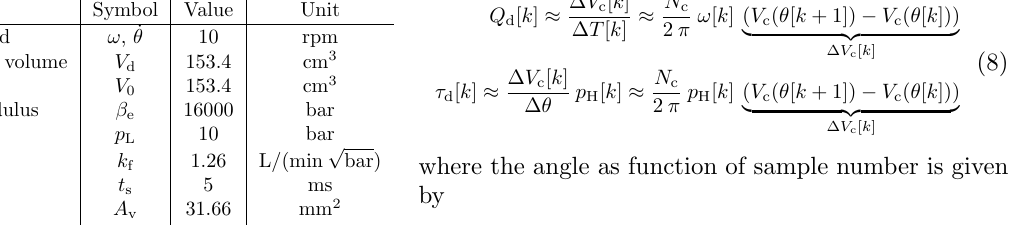
Table 1: Parameters of the 5 MW transmission Parameter